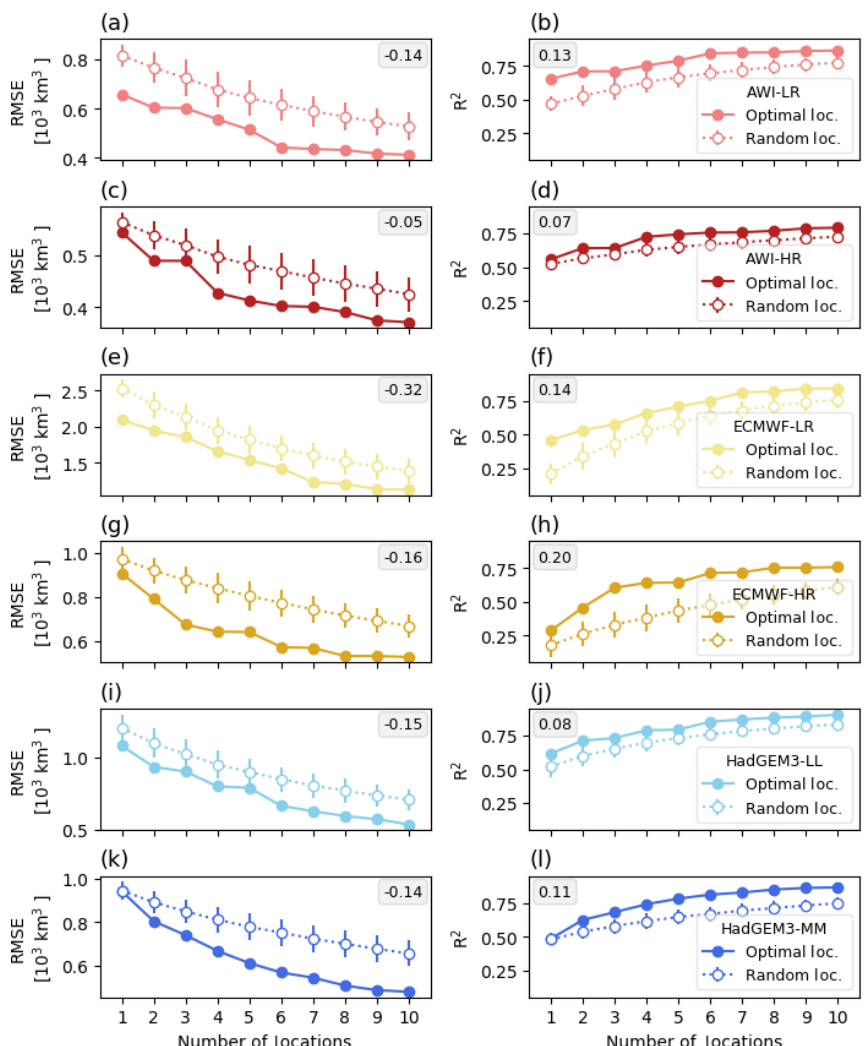
Figure 12. Root-mean-squared error (RMSE; left column) and coefficient of determination ( R 2 ; right column) calculated between the original and reconstructed SIV anomalies. The reconstructed SIV volume anomalies are based on the optimally selected locations following our methodology (full dots; same as in Fig. 11a, b), as well as by randomly chosen locations (empty dots). In the last case, 100 sets of 10 randomly chosen locations are used. For each of the 100 sets, the SIV anomaly is reconstructed using data from the first, the first–second, the first–third, ..., the first–10th locations. The random locations are all enclosed in the global region of influence defined (Fig. 9; black line). The vertical bars associated with the empty dots represent the 1 standard deviation from the 100 reconstructions. The inset numbers represent the average difference between the two curves shown in each